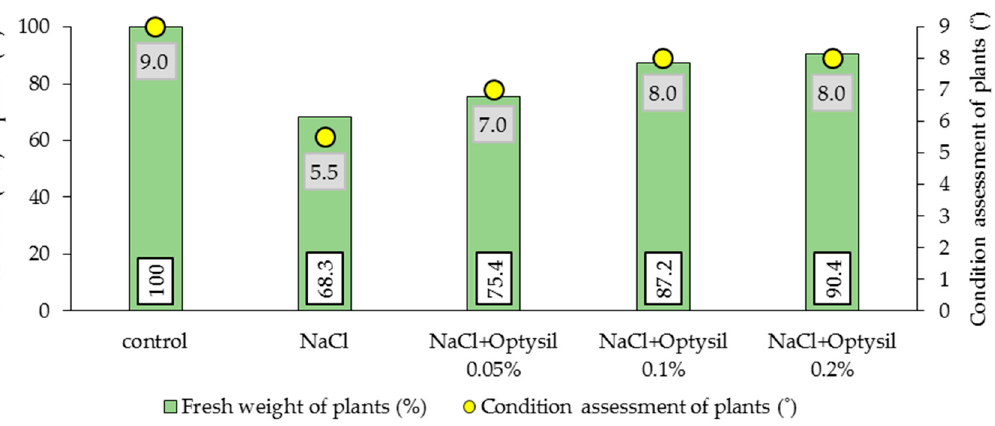
Figure 5. The effect of salinity and Si dose on the amount of fresh mass (FM) and condition of plants.